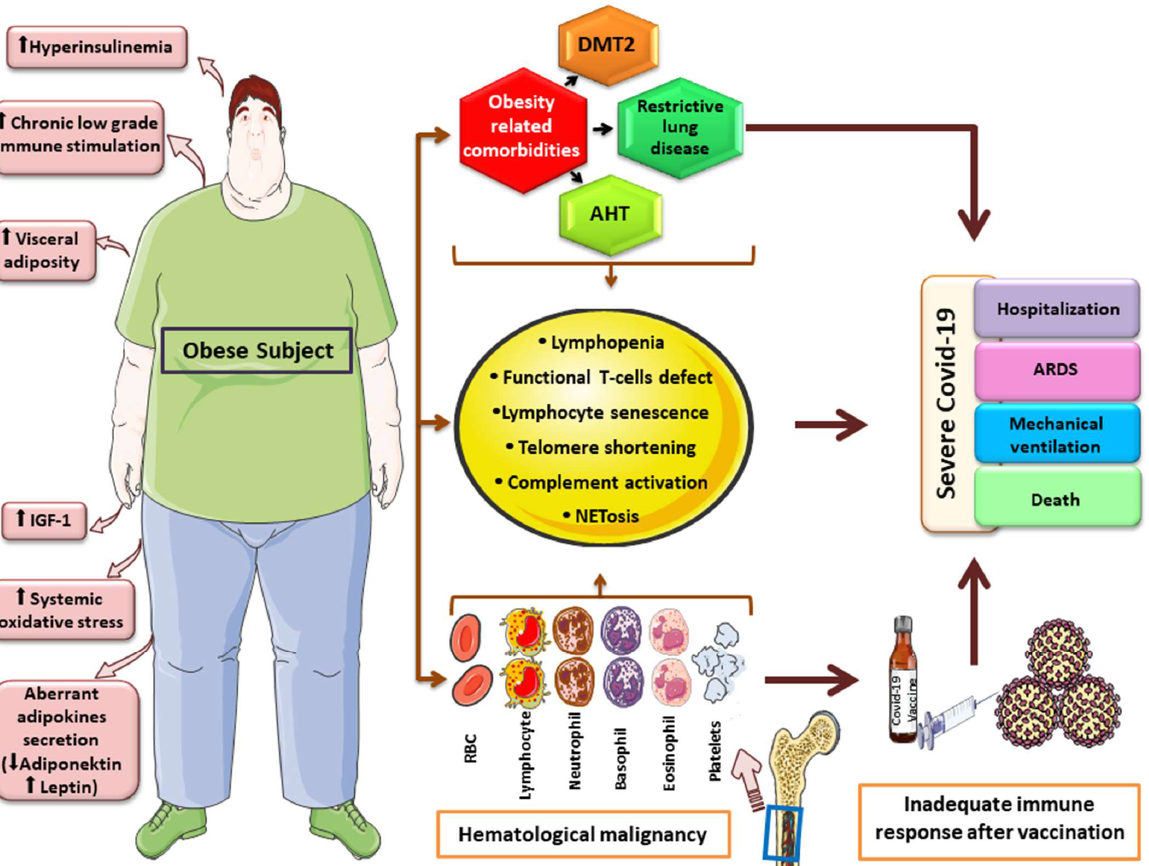
Figure 1. Graphical overview of factors and mechanisms linking obesity, hematologic malignancy and severe COVID-19 course. Obesity has been linked to carcinogenesis through aberrant cytokine and adipokine production, hyperinsulinemia, increase growth-factor levels (IGF-1), elevated oxida- tive-stress and chronic low-grade inflammation. Obesity-related comorbidities, along with features accompanying hematologic malignancies, such as quantitative and qualitative immune system de- fects and telomere shortening, may lead to an inadequate immune response after COVID-19 vac- cination and severe clinical outcomes. * This image was derived from the free medical site http://smart.servier.com/ (accessed on 31 March 2022) by Servier, licensed under a Creative Com- mons Attribution 3.0 Unported